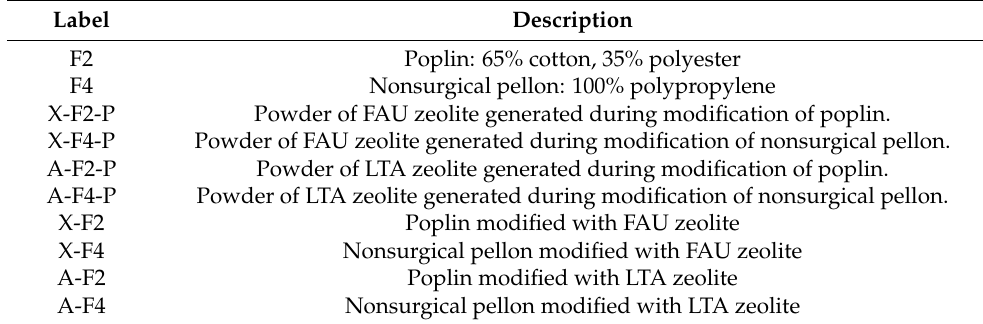
Table 1. Information of samples.